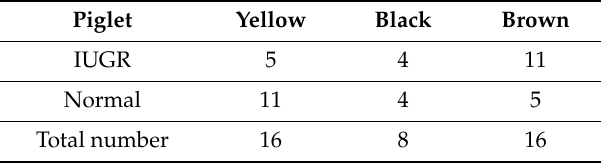
Table 1. Numbers of intrauterine growth-restricted (IUGR) and normal piglet colon content of different colors.